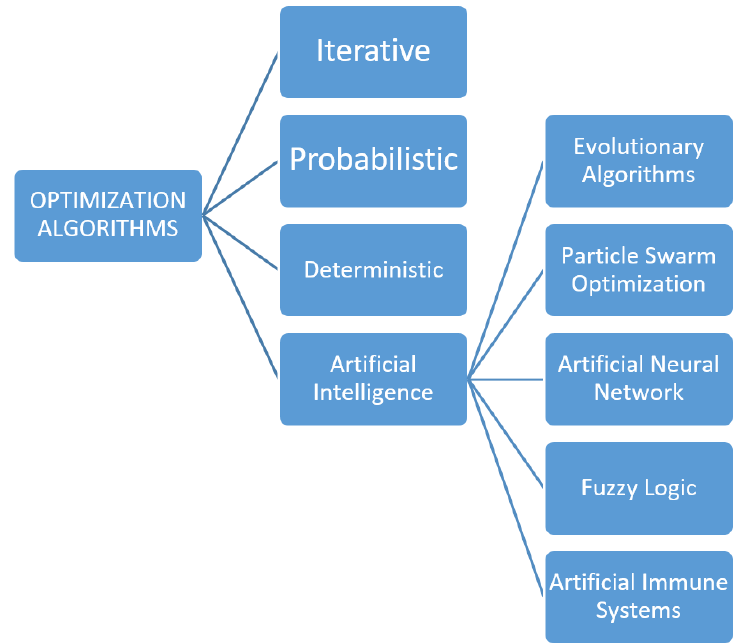
Figure 1. Division of optimization algorithms.